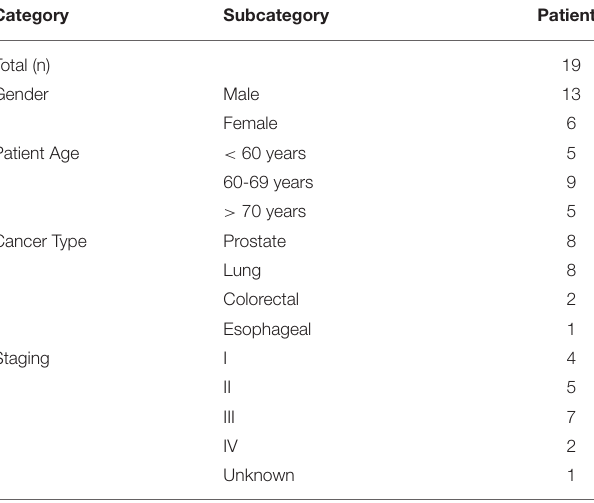
TABLE 3 | Cryopreserved PBMC patient